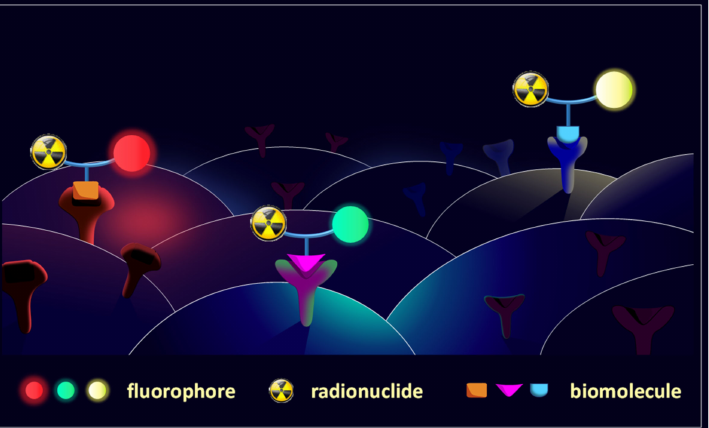
Figure 1. Schematic depiction of the concept of multimodal imaging agents for target-specific imaging via PET/OI. The hybrid compounds present a positron emitter (for PET imaging) and a fluorescent dye (for OI), both integrated in the structure of a target-specific biomolecule (e.g., peptide or antibody). This approach can be used to delineate a target structure by both imaging modalities and thus enables a correct and sensitive diagnosis and supports a following surgical